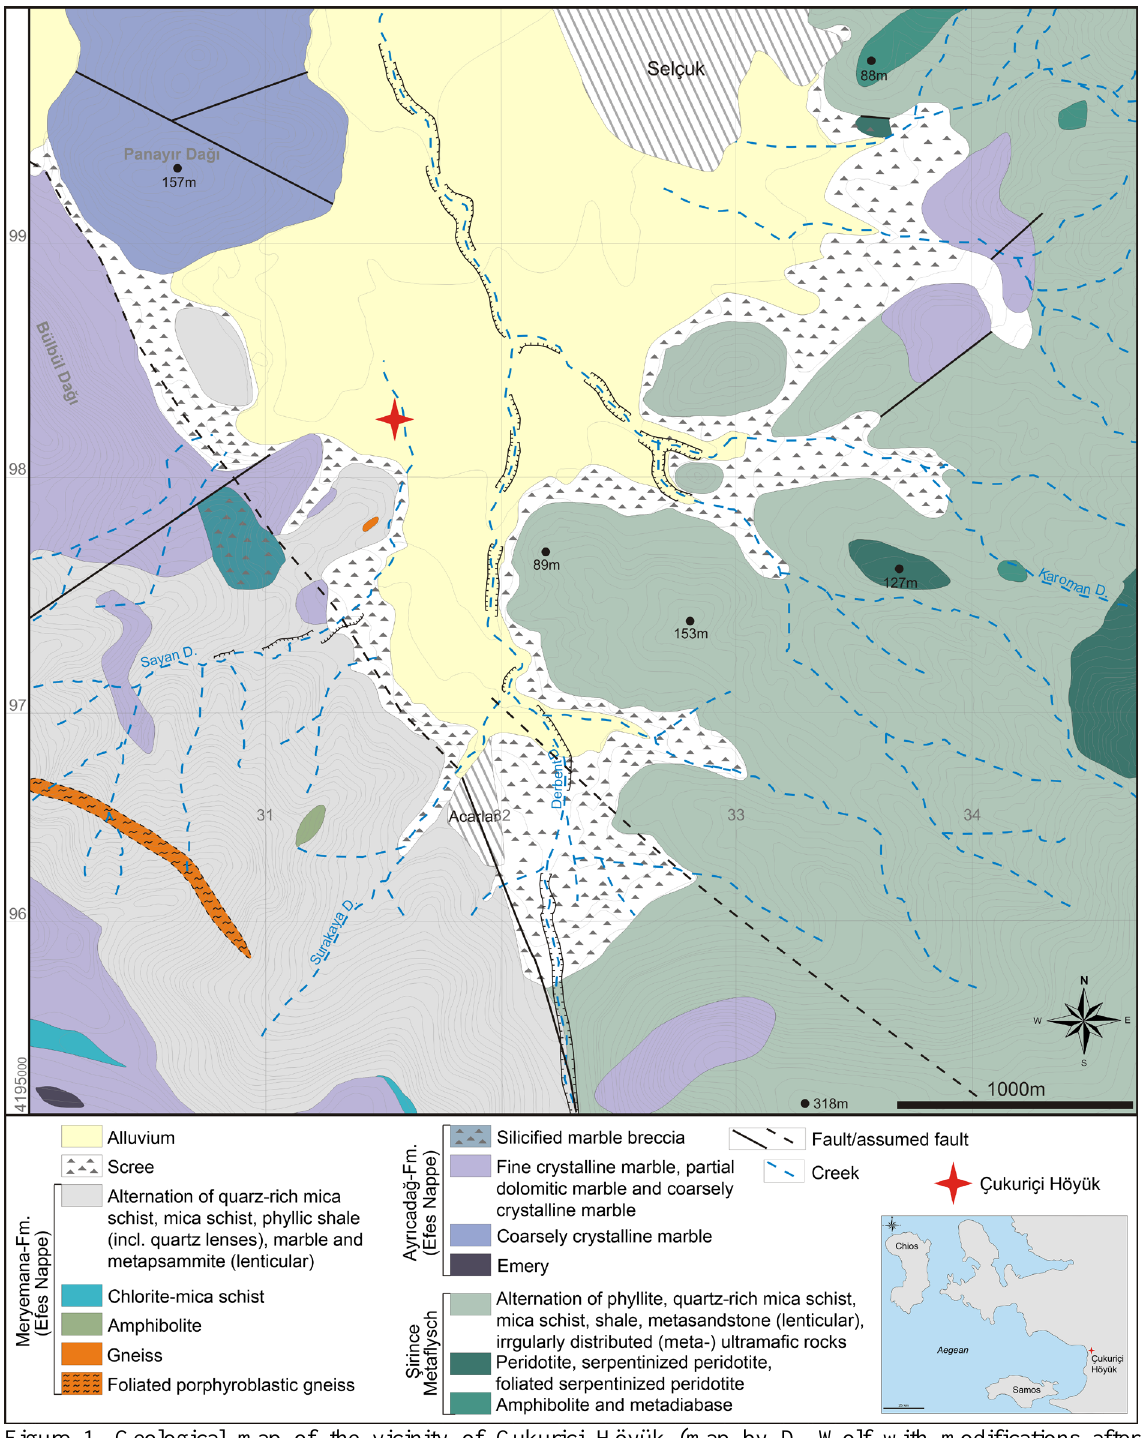
Figure 1. Geological map of the vicinity of Çukuriçi Höyük (map by D. Wolf with modifications after Çakmakoğlu 2007; Vetters